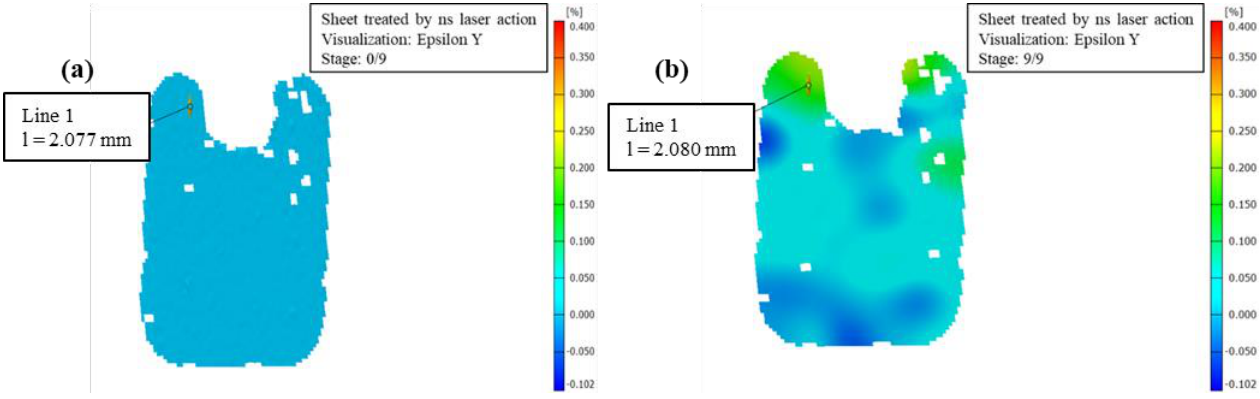
Figure 9. Nimonic 263 sheet, treated by ns laser action DIC measurement 1: ( a ) unloaded state, and ( b ) axial force 5 kN.